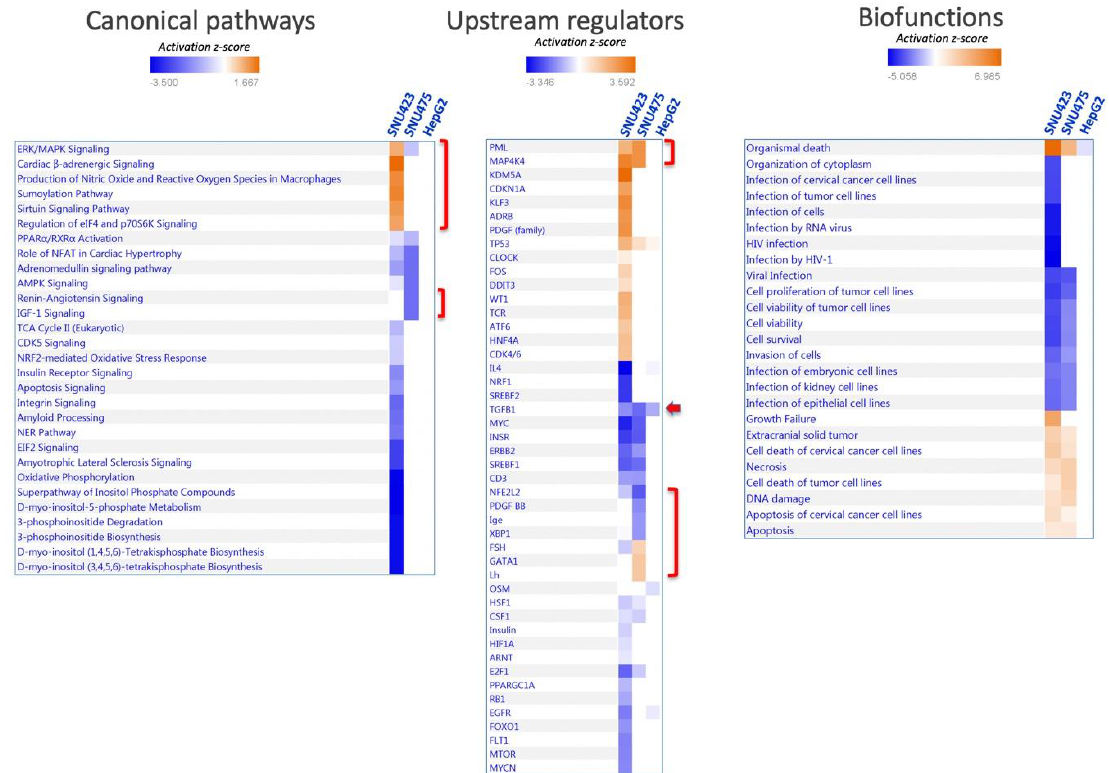
Figure 6. Enrichment analysis of proteins affected by Sorafenib treatment in each cell line. Proteins affected by Sorafenib treatment alone were analyzed using the IPA software in terms of canonical pathways, upstream regulators, and biofunctions as indicated, in the three cell lines studied. Brackets and arrow highlight elements that are commented on in the main text.